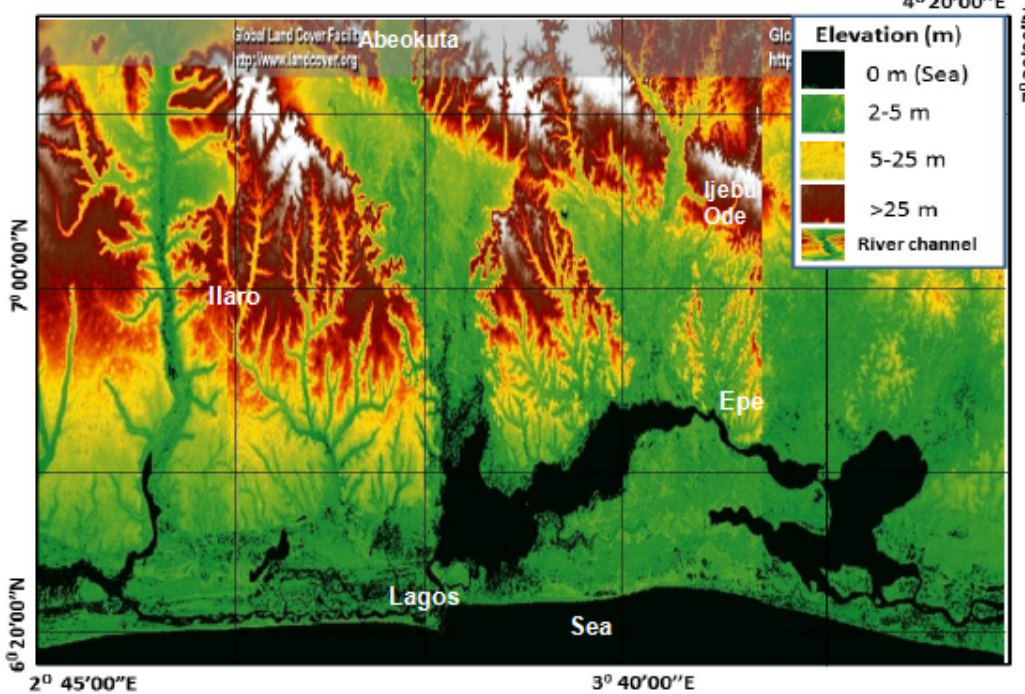
Figure 2. Digital Elevation Model (DEM ) of the Dahomey Basin showing surface water bodies in black.